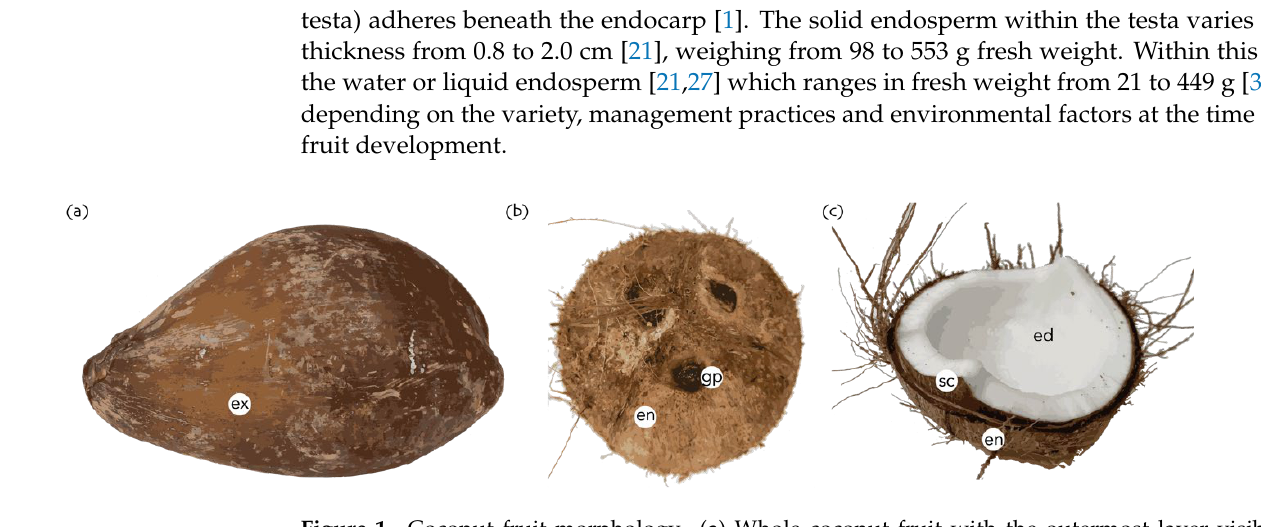
Figure 1. Coconut fruit morphology. ( a ) Whole coconut fruit with the outermost layer visible corresponding to the exocarp (ex); ( b ) a de-husked coconut fruit (exocarp and mesocarp removed), the three coconut eyes (including the germination pore [gp]) can be seen in the endocarp (en) as three dark brown circles; ( c ) coconut cut in half, displaying the inner fruit layer (endocarp [en]), the seed coat (testa [sc]) and endosperm (ed).